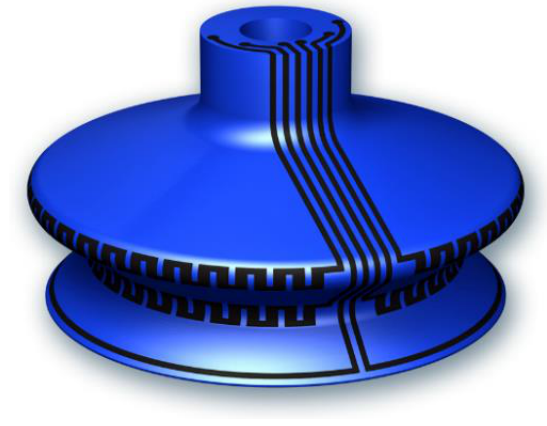
Figure 18. Design of SC with crenelated patterns.